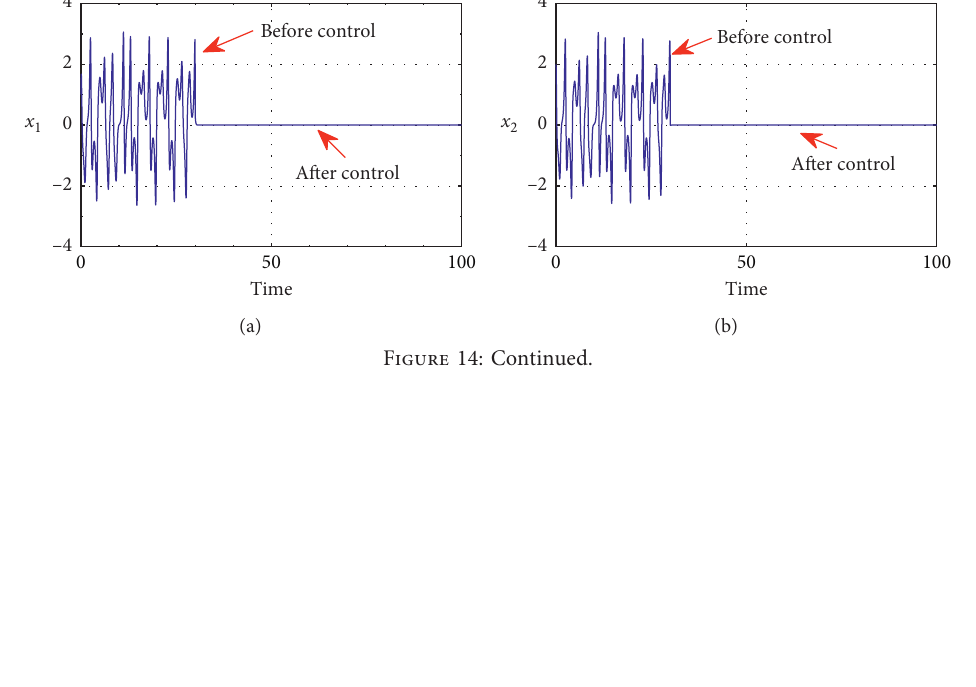
Figure 13: Fitness value versus generations in GA optimization process.